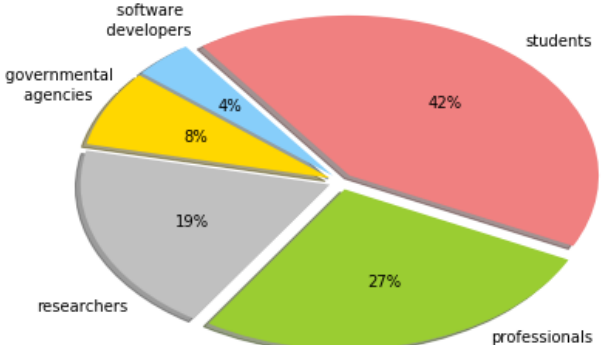
Figure 5. Target users for the educational material reported by the respondents to the second